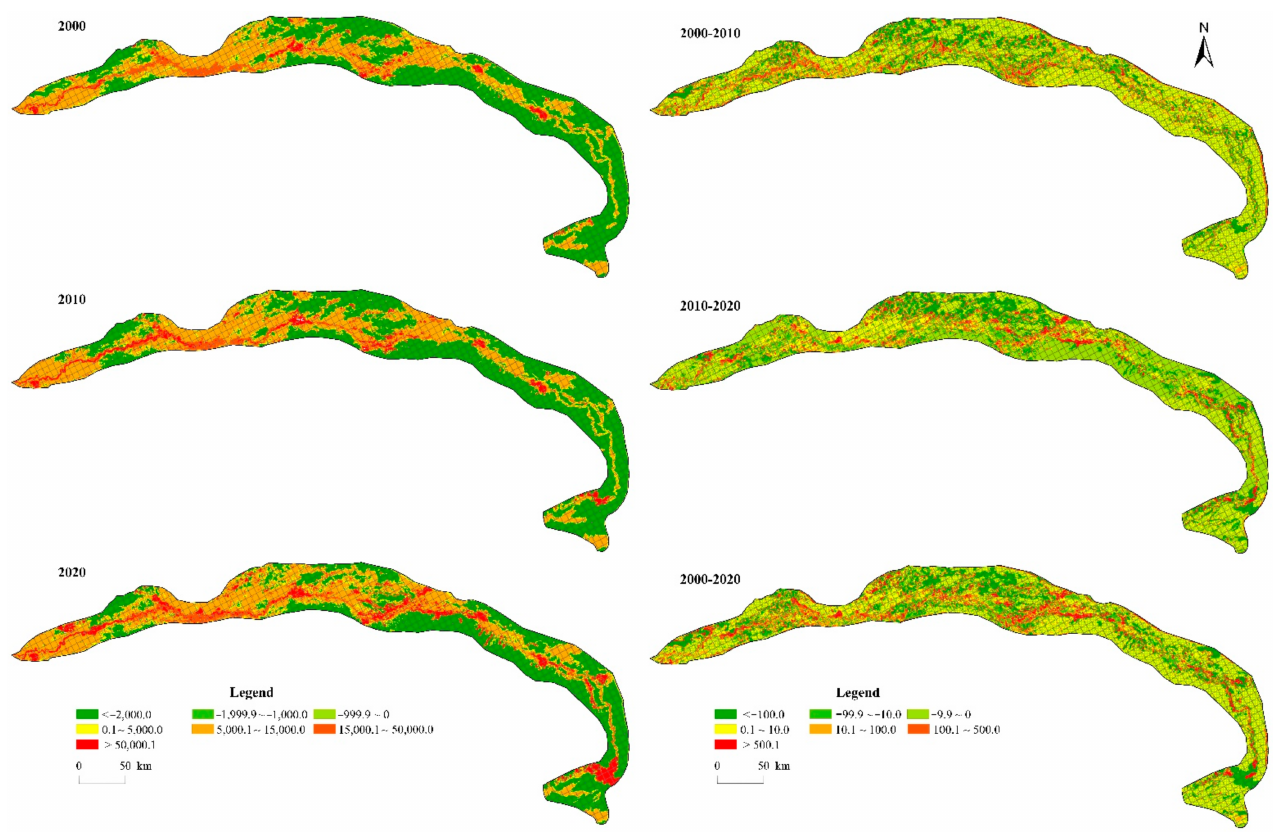
Figure 3. The spatial distribution pattern and variation in the ESV in relation to the main stream of the Tarim River (unit: million